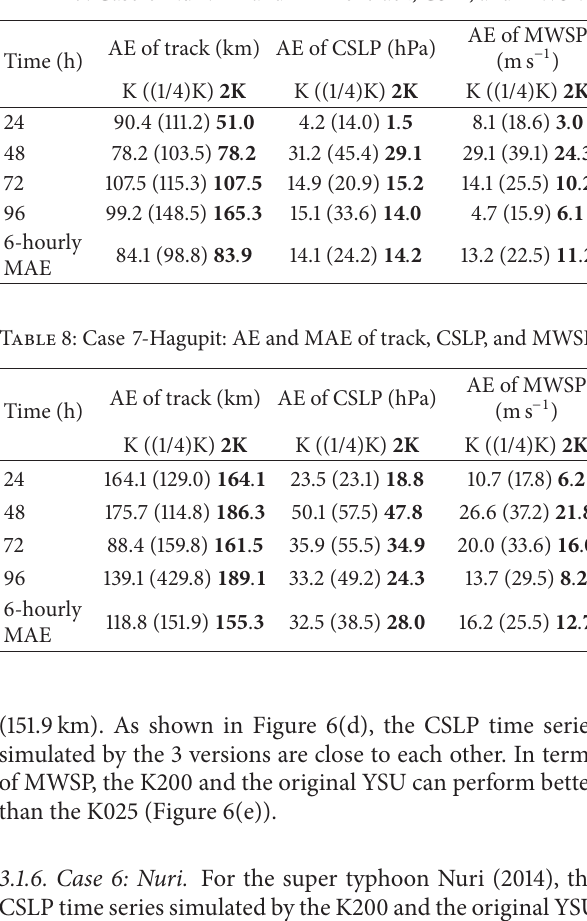
Table 7: Case 6-Nuri: AE and MAE of track, CSLP, and MWSP.